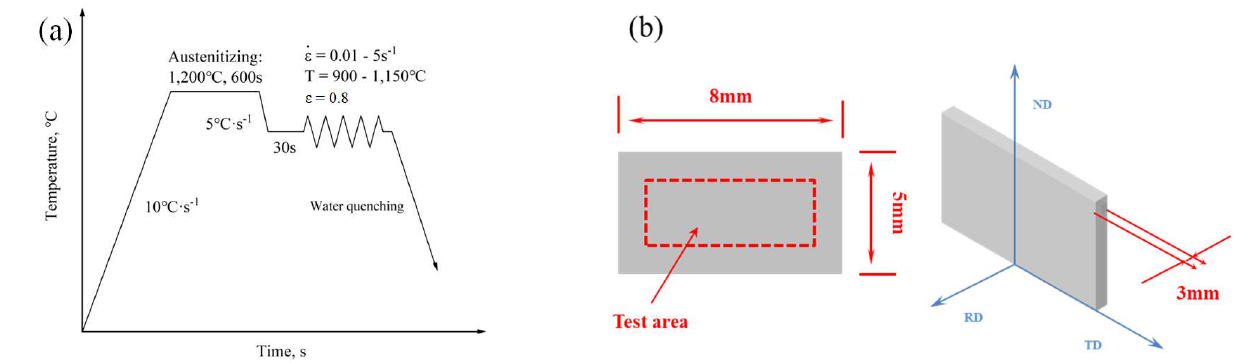
Figure 1. ( a ) Schematic diagram illustrating sequence of hot doformation tests, ( b ) sample size and test direction.